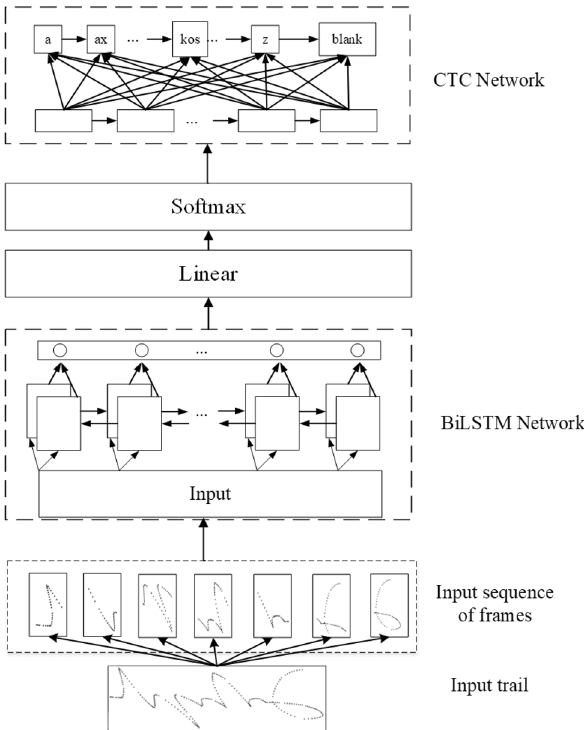
Figure 15. Architecture of the LSTM-CTC